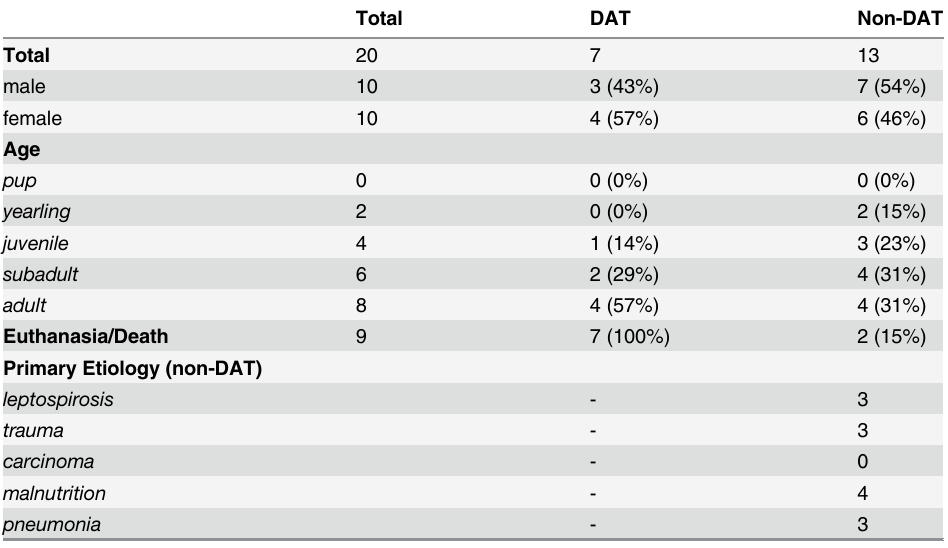
Table 5. Test set characteristics